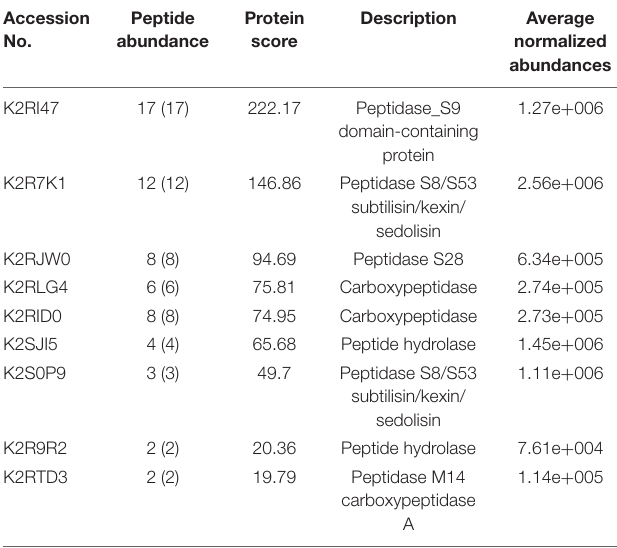
TABLE 1 | List of proteases present in the secretome of M. phaseolina identified using the LC-ESI-MS-MS. Accession No.